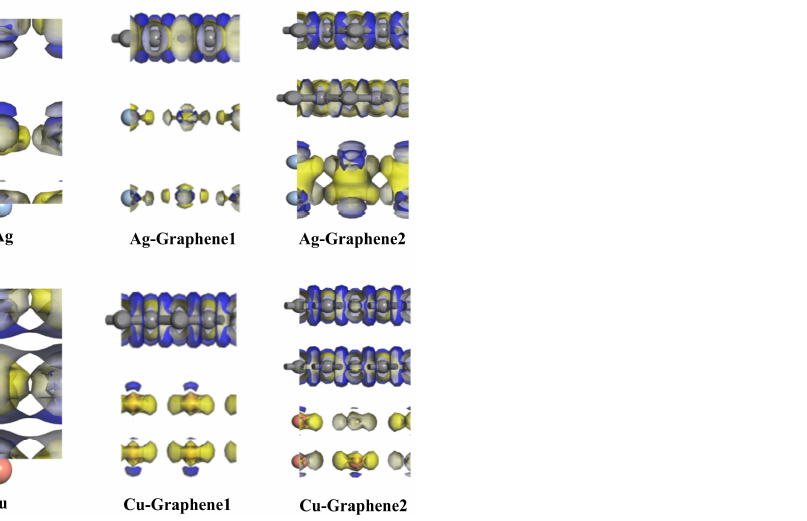
Figure 7. The three-dimensional differential charge density of different electrode plates.